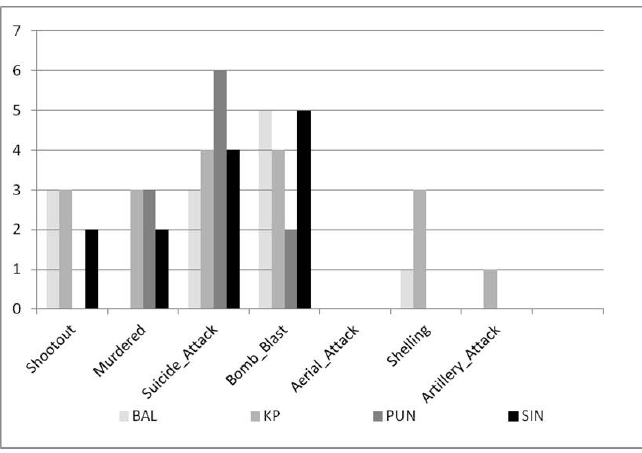
Figure 11. Number of clusters obtained for different Target Killing – Method combinations.